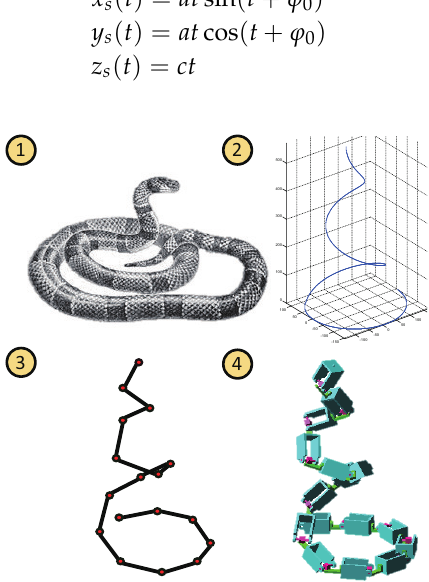
Figure 2. The similar macro shapes of a snake (label 1), a spiral curve (label 2), the line segments model after the shape-fitting algorithm (label 3) and the simplified simulation model (label